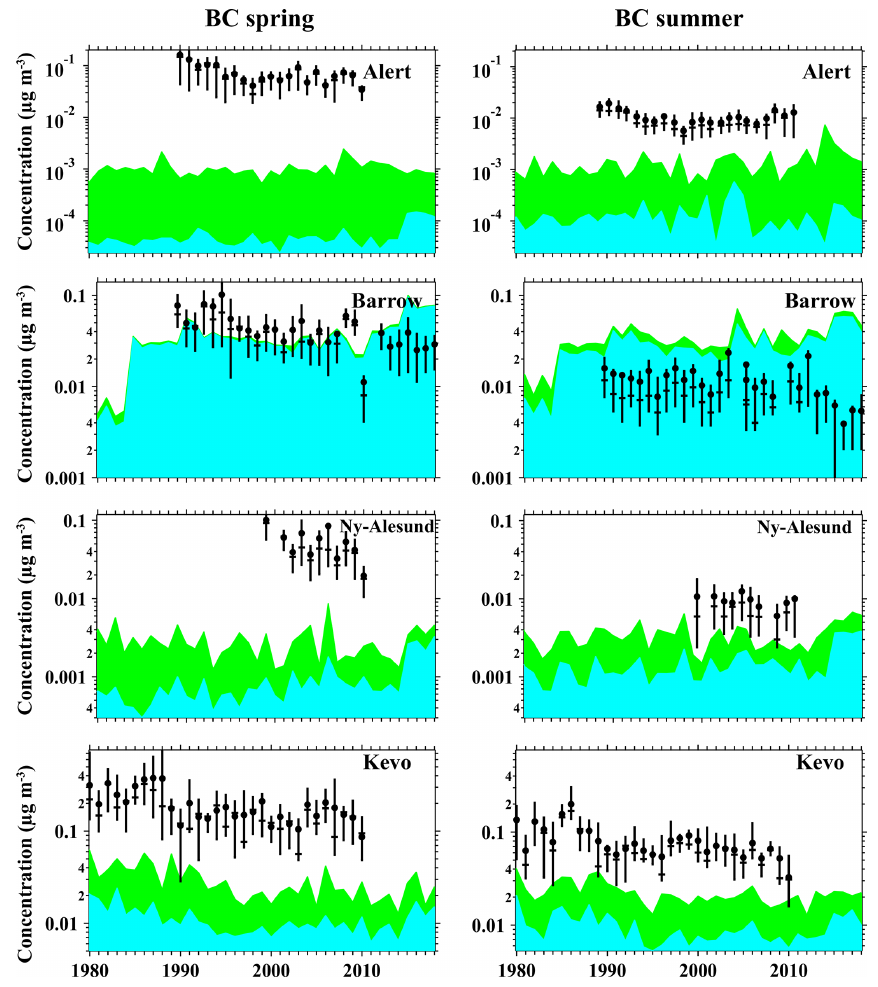
Figure 4. Same as Fig. 3 but for surface BC (µgm − 3 ) at four (Alert, Barrow, Ny-Ålesund, Kevo) Arctic sites.